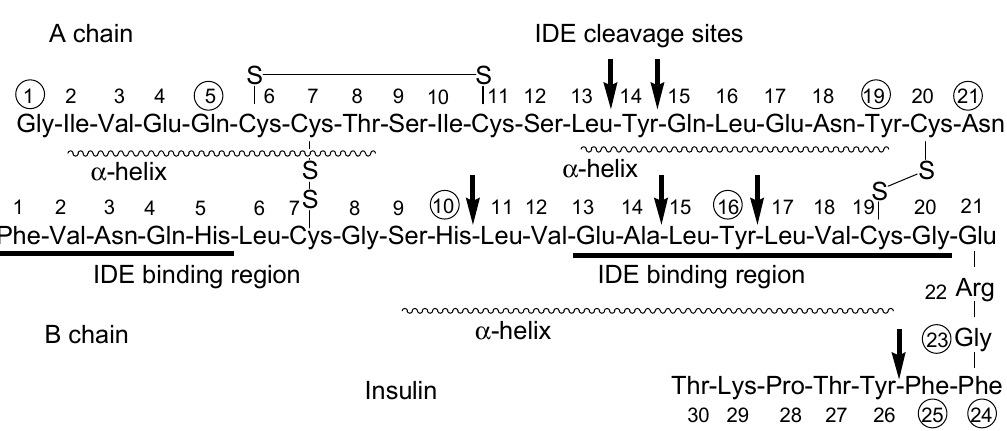
Figure 3. N -Methylated cyclic structure of cyclosporine.